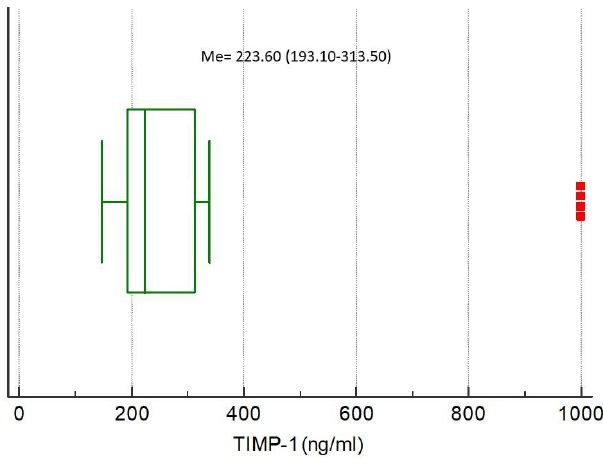
Figure 5. Distribution of the matrix metalloproteinase 9 (MMP-9) concentrations in the study population. Squares indicate outliers and far out values illustrated as single data points.